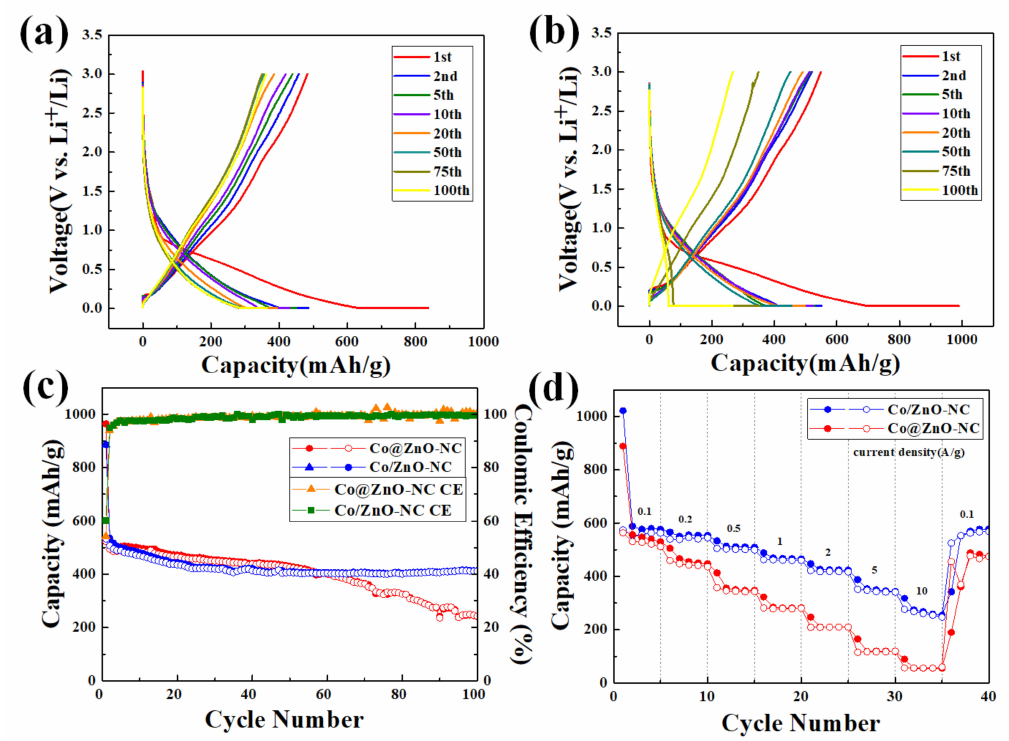
Figure 8. Charge/discharge curves of ( a ) Co/ZnO-NC and ( b ) Co@ZnO-NC at 200 mA/g; ( c ) Cycling performance of Co@ZnO-NC and Co/ZnO-NC at 200 mA/g; ( d ) Rate performance of Co@ZnO-NC and